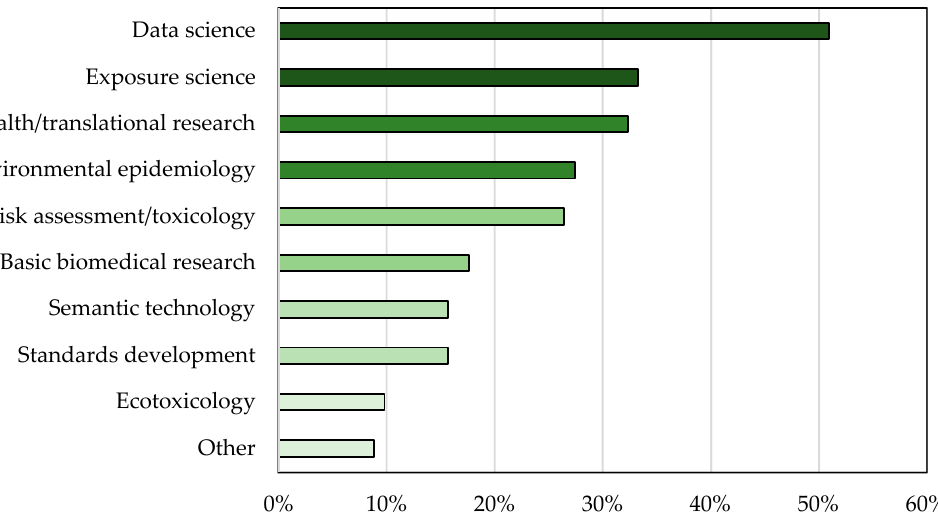
Figure 2. Research areas and disciplines of September 2021 EHLC workshop participants.